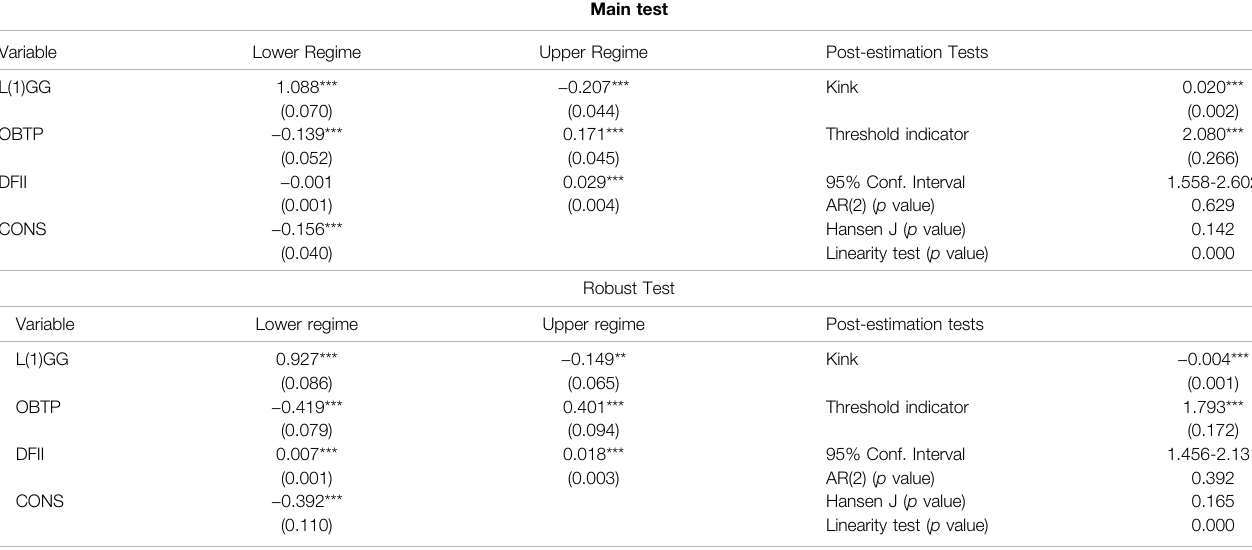
TABLE 7 | Results for the threshold effect of output biased technological progress (OBTP) on green growth